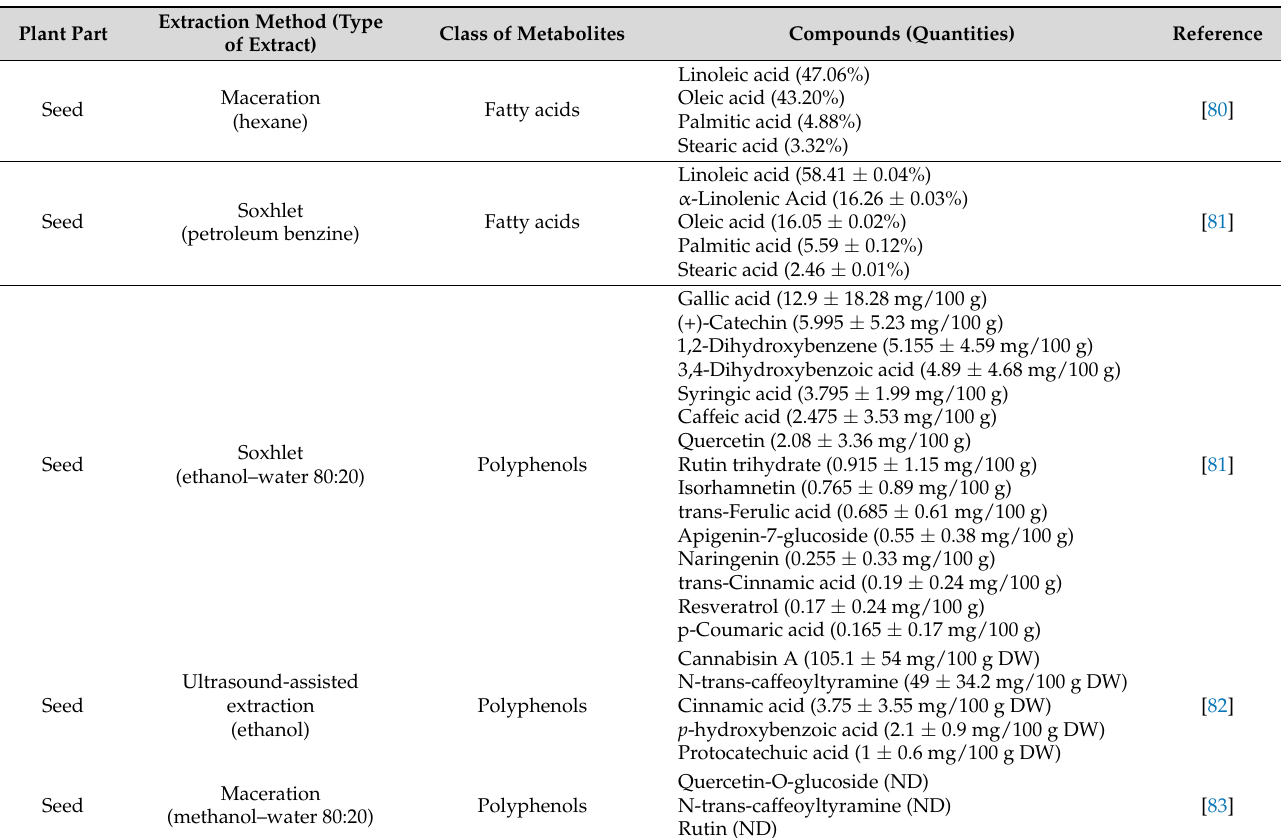
Table 2. Chemical composition of Cannabis sativa different plant